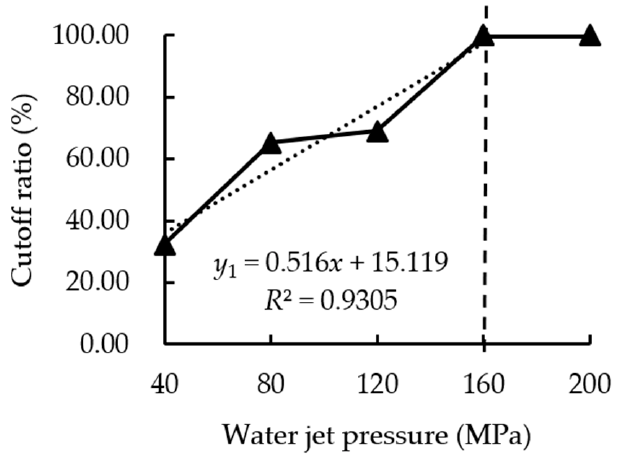
Figure 6. In fl uence of the water jet pressure on the cuto ff ratio. Figure 6. Influence of the water jet pressure on the cutoff